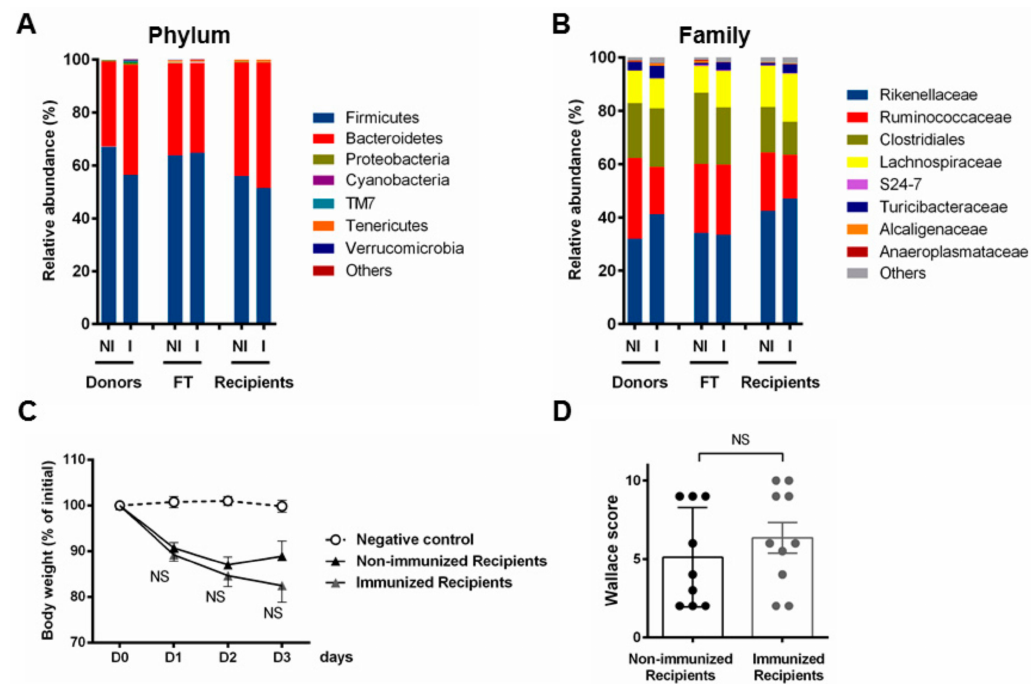
Figure 5. Fecal transplantation fails to induce substantial changes in microbiota and does not transfer resistance to colitis. Mean relative abundance at the phylum ( A ) and family level ( B ) for either non-immunized (NI) and immunized (I) feces of donor mice, n = 5 per group; the respective representative pooled fecal transplants (FT) (after resuspension, n = 1) and the corresponding feces of recipient mice, at day 36, n = 5 per group. Results are expressed as % of the total OTU number. ( C ) Percentage of loss of initial weight (prior colitis, at day 36 = D0) expressed as the comparison of individual weights recorded at killing (day 39 = D3) as means ± SEM, and ( D ) macroscopic clinical (Wallace) scores of colons at day 39 in both non-immunized and immunized recipient group of mice; means ± SEM. n = 10 per group for colitis evaluation parameters ( C and D ); NS, not significantly di ff erent from the positive control